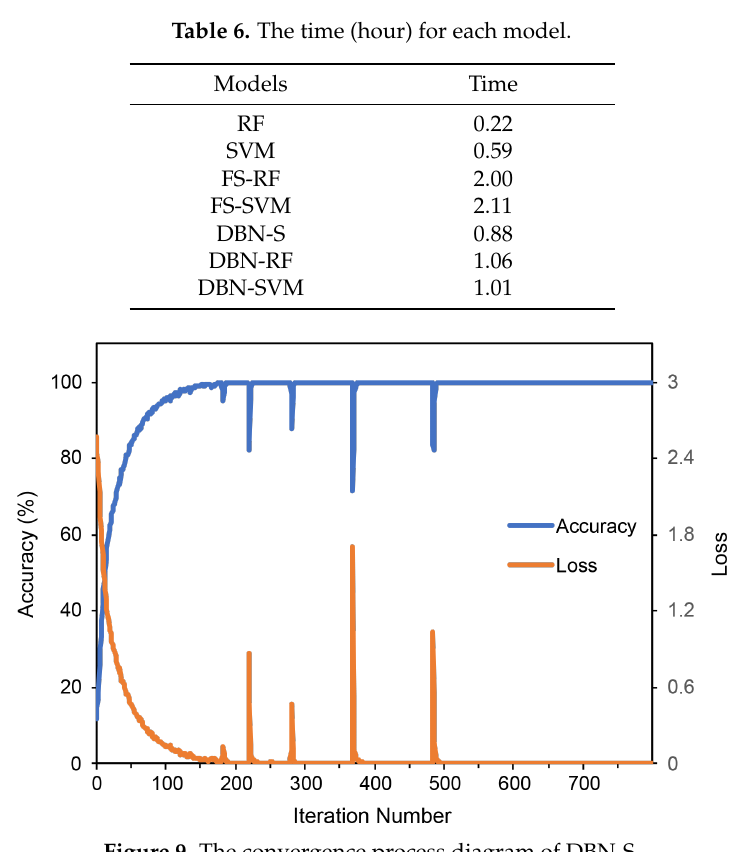
Figure 9. The convergence process diagram of DBN-S.